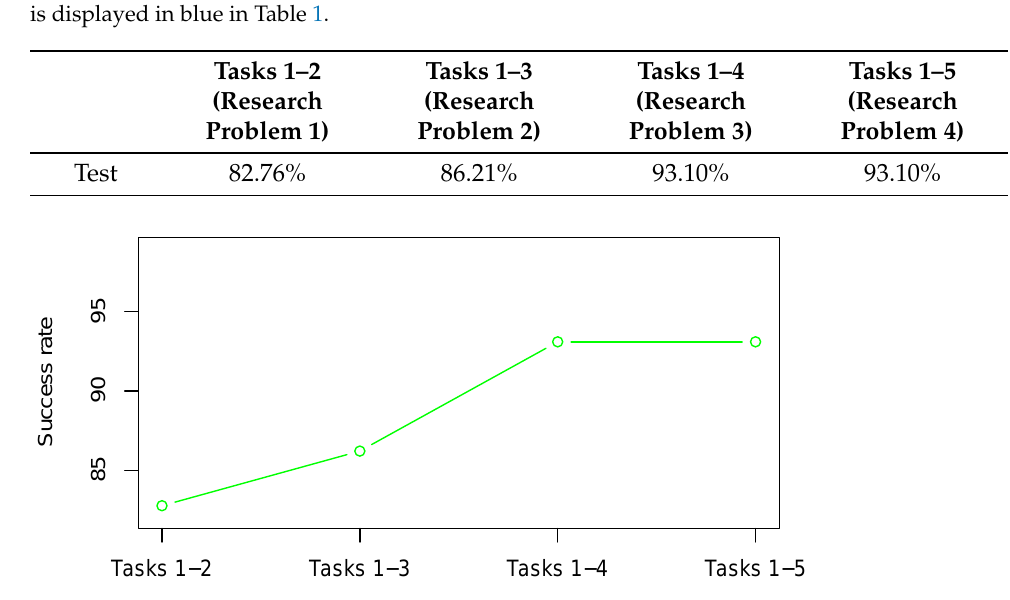
Figure 4. Display of the success rates in Table 2. The OX-axis shows the tasks used in the model to predict the interval of the average grade; it goes from Tasks 1 and 2 (research problem 1) in the left corner of the axis to Tasks 1, 2, 3, 4, and 5 (research problem 4) in the right